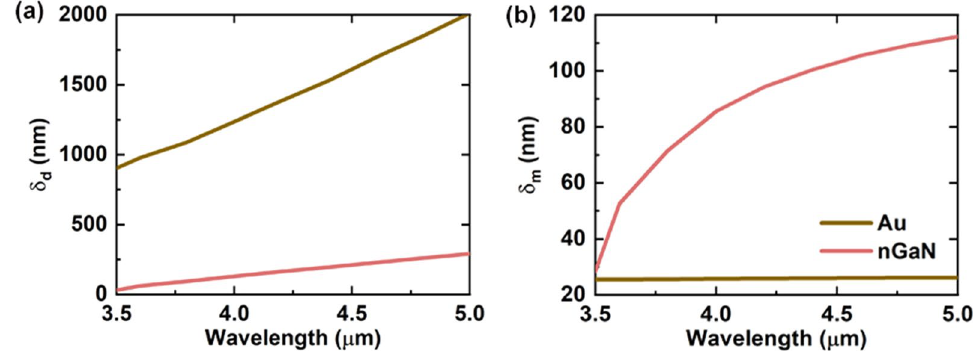
Fig. 3 Wavelength-dependent penetration depth into dielectric a and metallic b layer of SPPs on Au and nGaN substrates